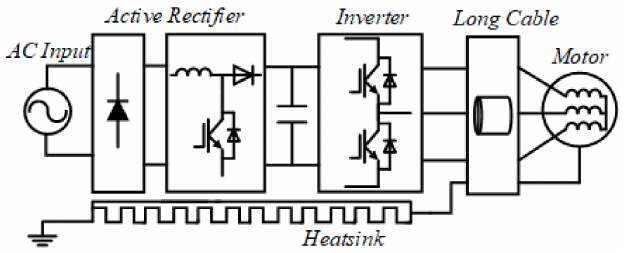
Figure 8. Experimental platform to validate the proposed